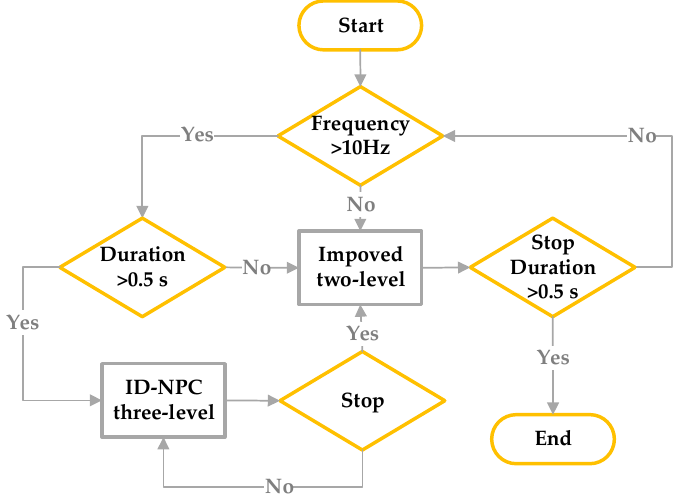
Figure 13. The flowchart of modulation conversion.